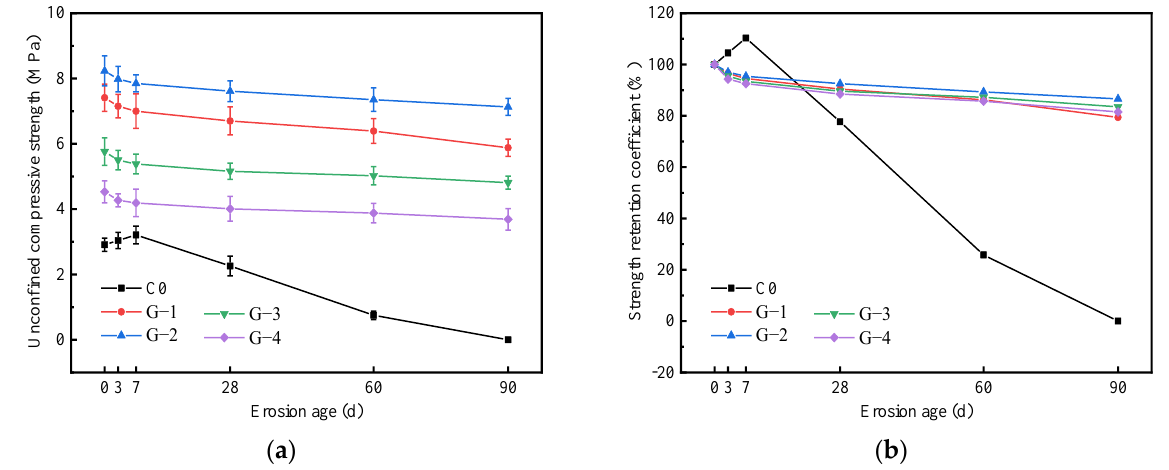
Figure 5. Strength development of stabilized soil immersed in sulfate erosion solution: ( a ) UCS value; ( b ) strength retention coefficient.